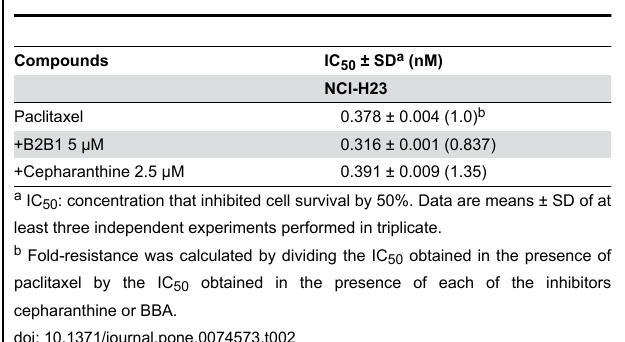
Table 2. The effect of BBA on the sensitivity of NCI-H23 cells to paclitaxel.